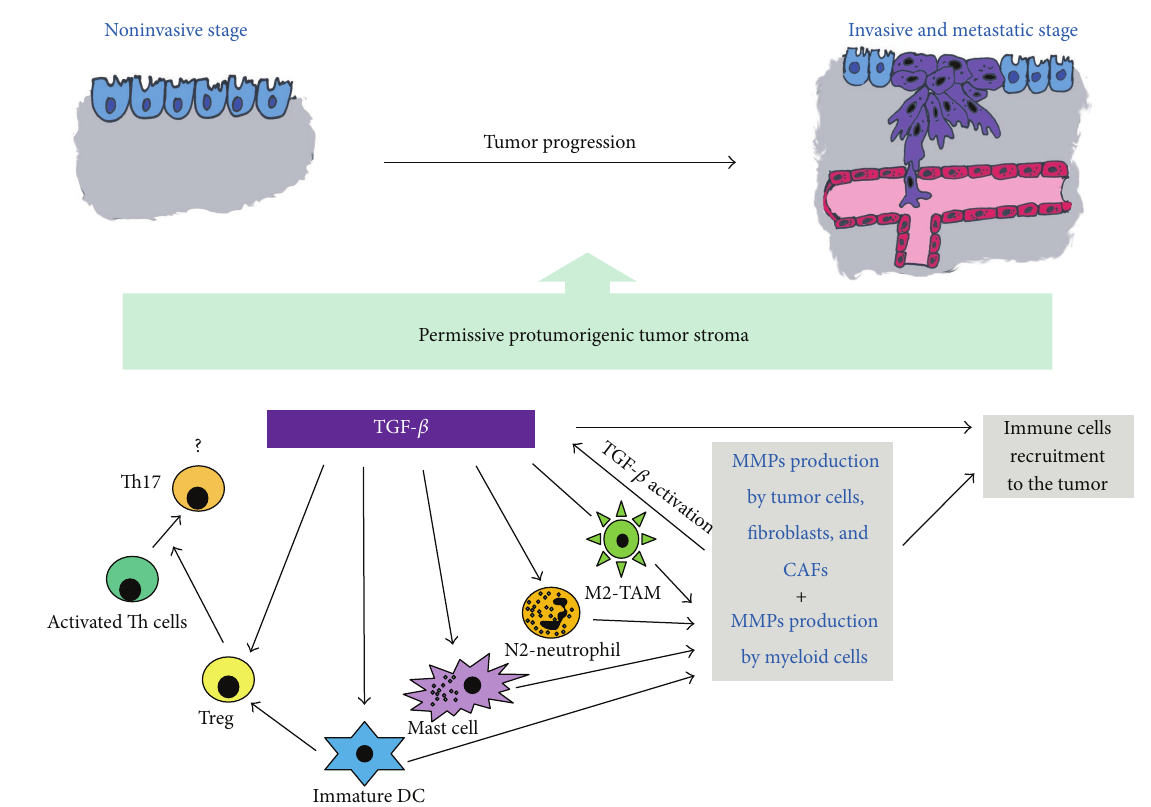
Figure2:TGF- 𝛽 -MMPssystemandtumorstroma-infiltratingmyeloidcellsinterplayduringtumorprogression.MMPsproducedbyresident tumor stroma cells, such as cancer associated fibroblast (CAFs) or pericytes, may activate latent TGF- 𝛽 , and both can enhance the recruitment of immune cells, leukocytes, and myeloid cells to the tumor stroma. TGF- 𝛽 , in turn, may regulate myeloid cells phenotype, to promote the protumorigenic M2 phenotype of tumor-associated macrophages (M2-TAMs) and the N2 phenotype of the tumor associated neutrophils (N2-TANs). At the same time, TGF- 𝛽 regulates mast cells degranulation and stimulates the expression of IL-6. In addition, mast cells produce TGF- 𝛽 , incrementing the level of the factor in tumor stroma. Meanwhile, TGF- 𝛽 maintains dendritic cells (DC) in an immature stage, which in turn, can activate regulatory T cells (Tregs) to enhance immunosuppression. Stimulated Tregs in concert with mast cell produce IL-6 and induce the differentiation of Th17 cells which in turn may collaborate in the proinflammatory tumor response. Tumor stroma-infiltrating myeloid cells also produce large amounts of MMPs which can intensify TGF- 𝛽 activation, and the TGF- 𝛽 -MMPs-myeloid cells interplay to induce a tumor growth permissive stroma supporting tumor progression, thus strengthening the cancer cells invasion and metastasis.